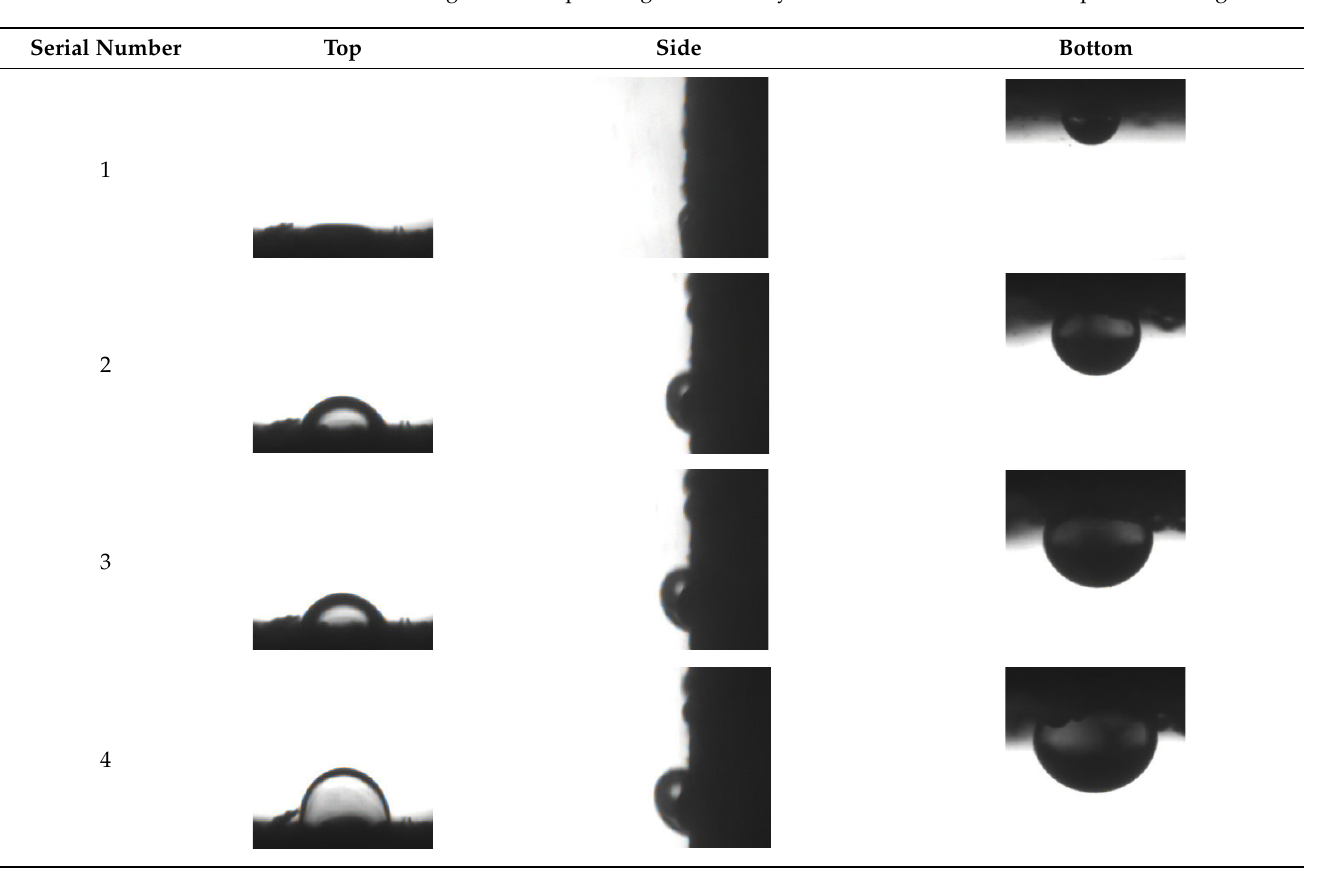
Table 3. Image of oil drop during surfactant dynamic imbibition in different positions of tight core.